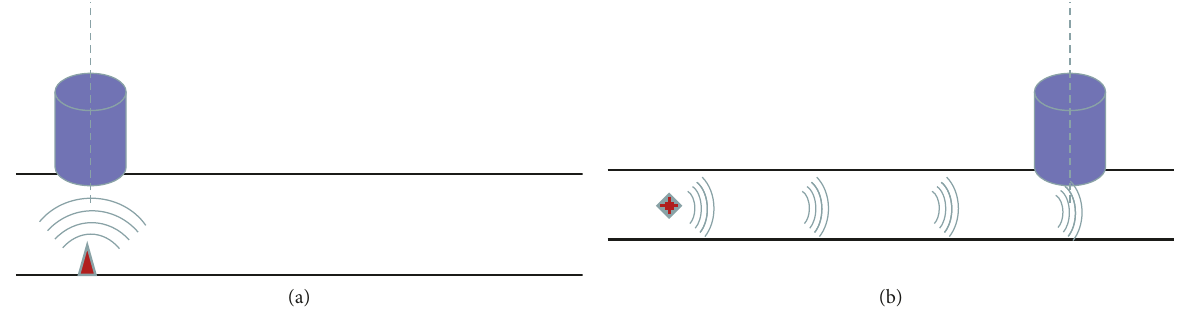
Figure 5: Wavefronts can occur perpendicular (a) or parallel (b) to the sensor axis.